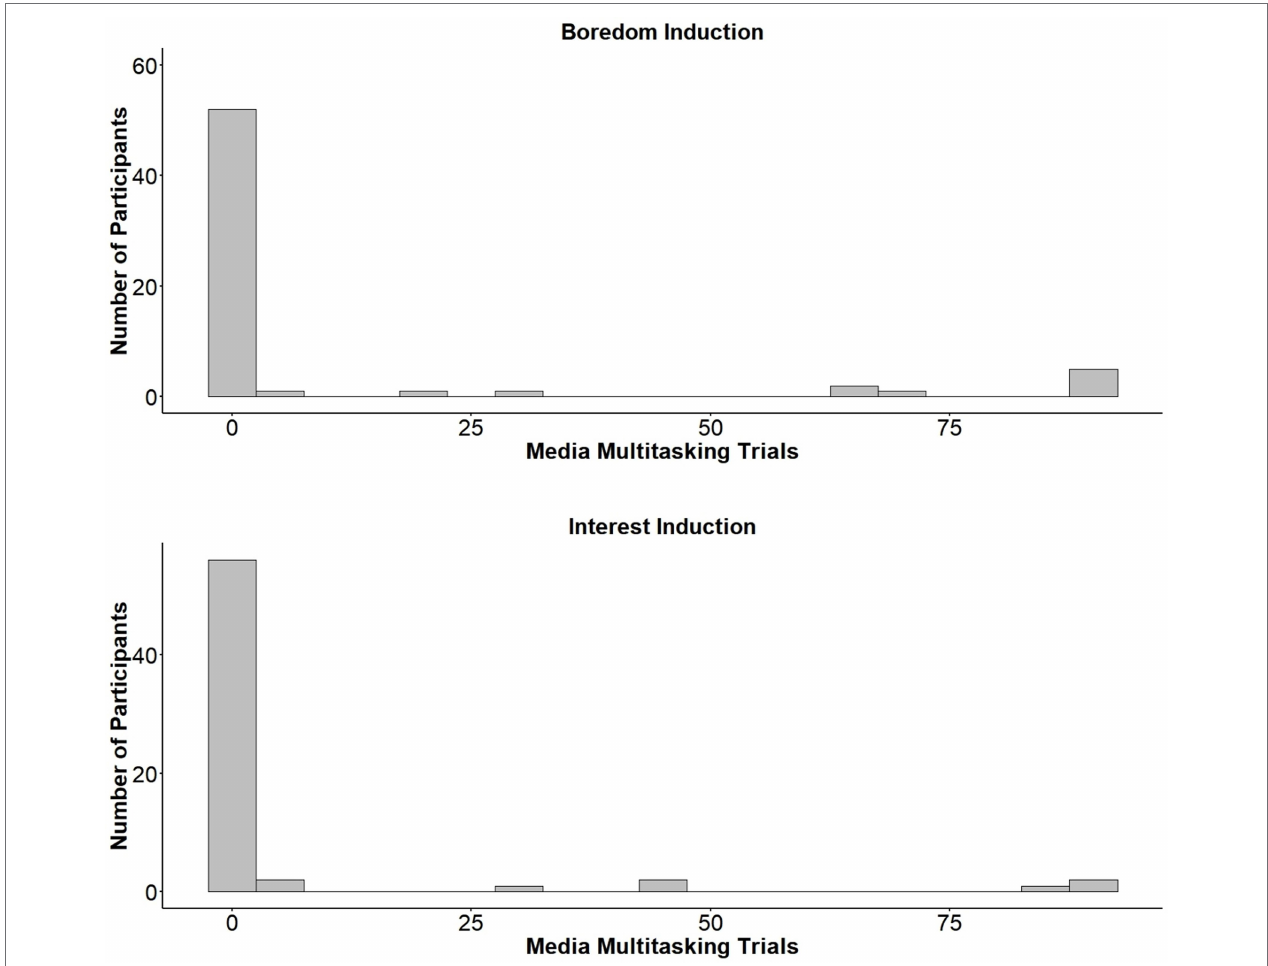
FIGURE 7 | Histograms showing the total number of participants who media multitasked for a given number of trials, based on whether they viewed the boredom ( top ) or interest ( bottom ) induction videos.